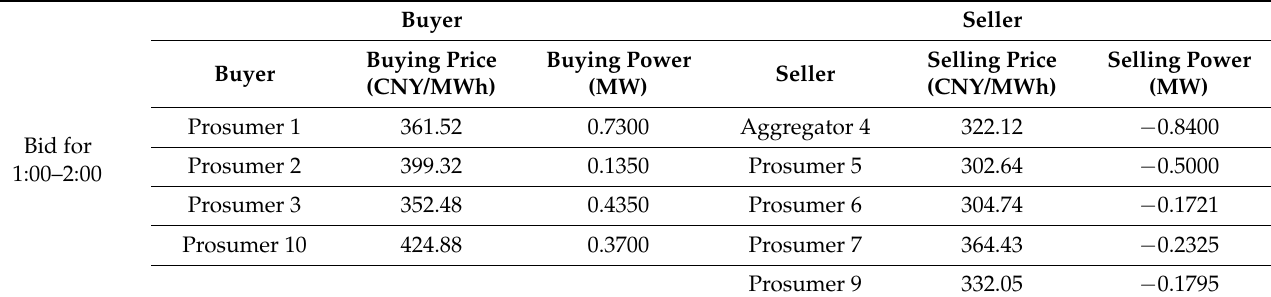
Table 7. The information releasing of all prosumers at 1:00–2:00 on the scenario of prosumer 4 and 8 as aggregator 4.